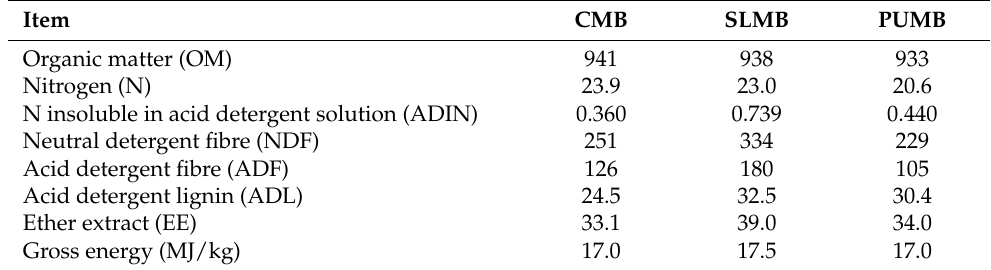
Table 3. Chemical composition (g/kg dry matter (DM)) and gross energy content of multinutrient blocks including no seaweed (Control; CMB), Saccharina latissima (SLMB) or Porphyra umbilicalis